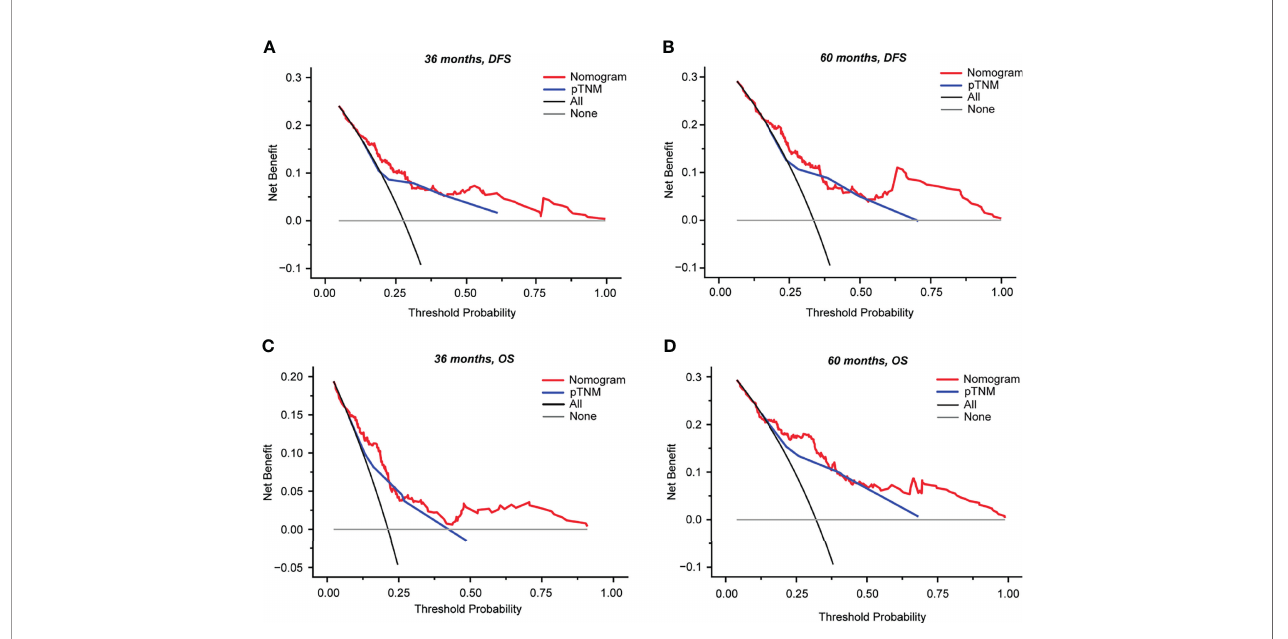
FIGURE 6 | Decision curve analysis (DCA) of the nomograms and model comparisons with pTNM stage in 254 patients with stage II – III colorectal cancer (CRC). DCA was performed to determine the clinical usefulness of the nomogram via quantifying the net bene fi ts at different threshold probabilities. The x -axis and y -axis represent the threshold probability and net bene fi t, respectively. (A, B) DCA curves for DFS at 36 months (A) and at 60 months (B) . (C, D) DCA curves for OS at 36 months (C) and at 60 months (D) . Gray horizontal lines denote that none of the patients received intervention. Black lines represent all patients who received intervention. Red lines represent the net bene fi t of model prediction. Blue lines represent the net bene fi t of pTNM prediction. DCA, decision curve analysis; OS, overall survival; DFS, disease-free survival; pTNM, pathological TNM based on the 8th edition of the American Joint Committee on Cancer